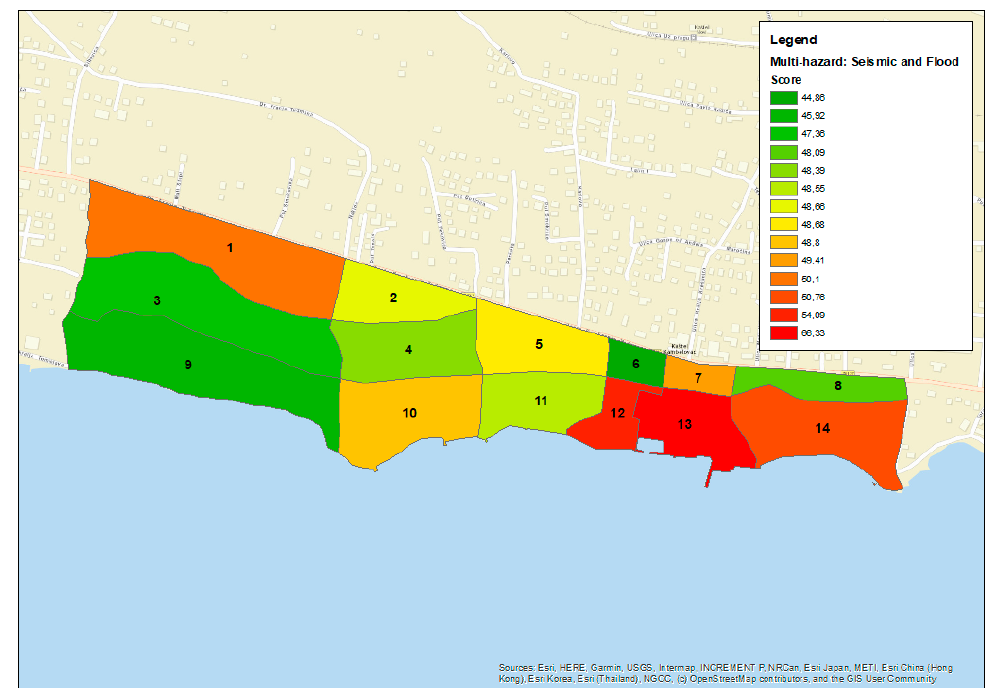
Figure 18. GIS visualization of risk for seismic and flood hazard for Level 3 (Scenario S-F L3). Table 5. An example of criteria weights for combined seismic–flood–extreme waves risk for Scenario S-F-EW Level